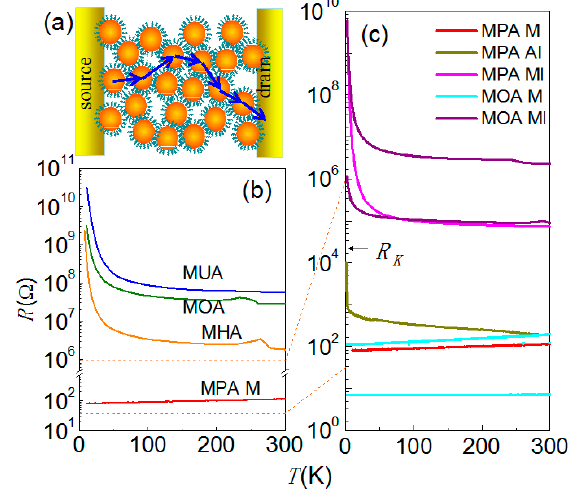
Figure 2. ( a ) the schematic of a two-terminal device; ( b ) the R vs. T curves for MUA, MOA, MHA and metallic MPA (MPA M) devices. The MPA M device shows metallic behavior while the others show insulating behavior; ( c ) R ( T ) curves for various MPA and e-beam exposed MOA devices. MPA devices show